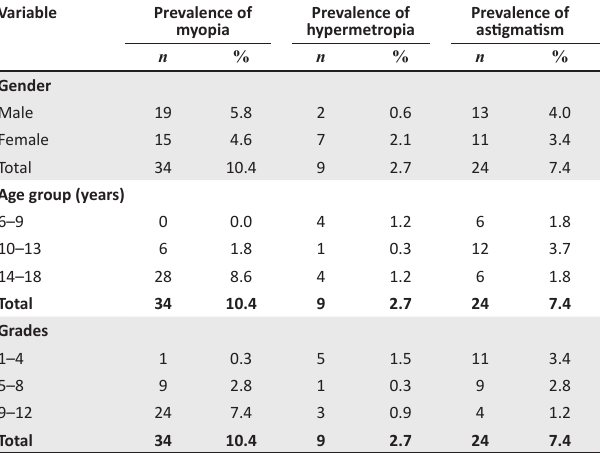
TABLE 6: Prevalence of refractive error according to gender, age and